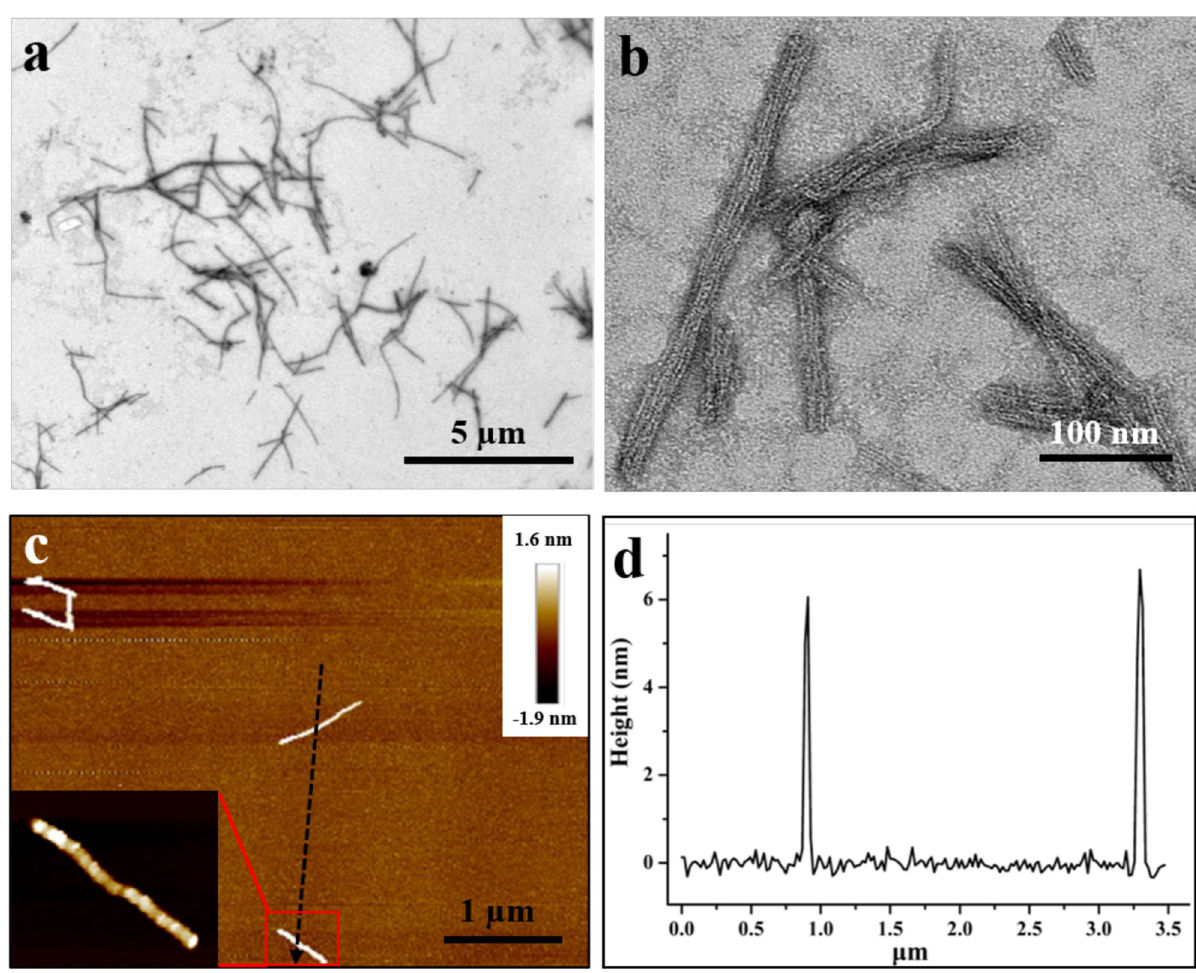
Fig. 5 Characterization of the 1D fi laments constructed by 12.0 µ M FLAL-L and 15% PEG1500. a Low-magni fi cation TEM view of FLAL-L fi laments. b Enlargement of FLAL-L fi laments. c Atomic force microscopic (AFM) micrographs of the 1D fi laments. d Height distributions measured along the black arrow in c